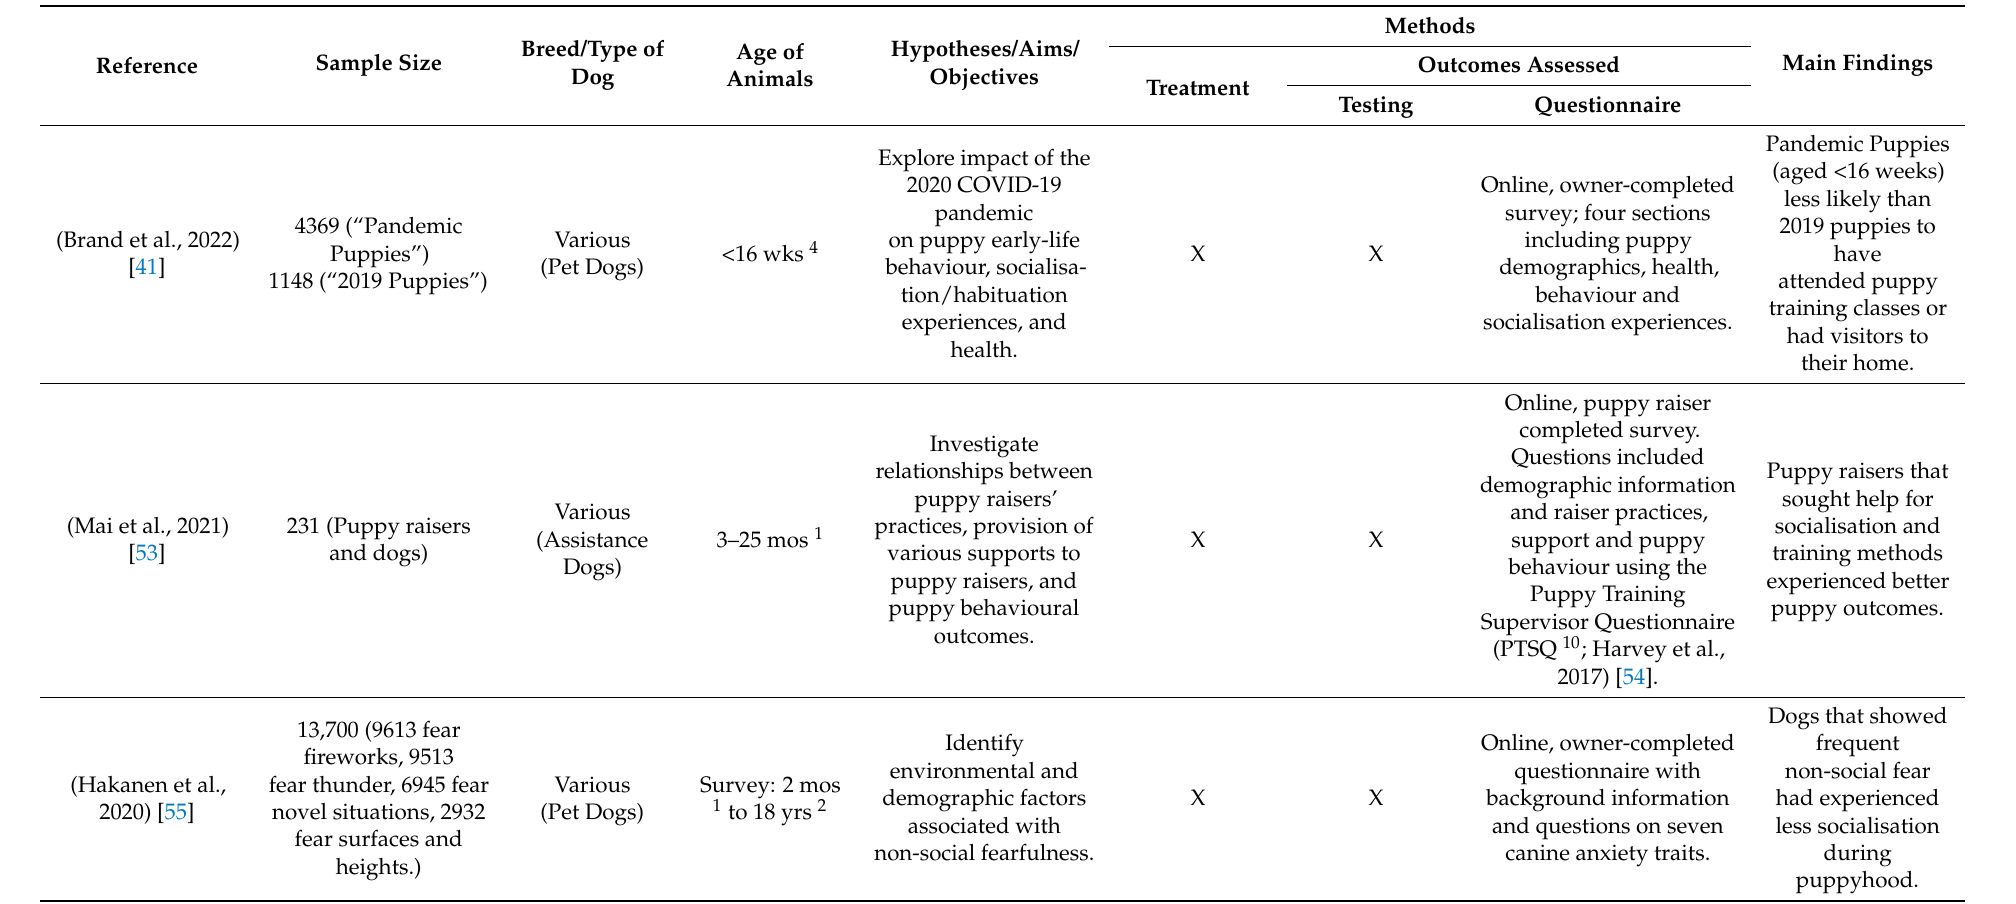
Table 1. All 29 studies that passed quality assessment to be included in main